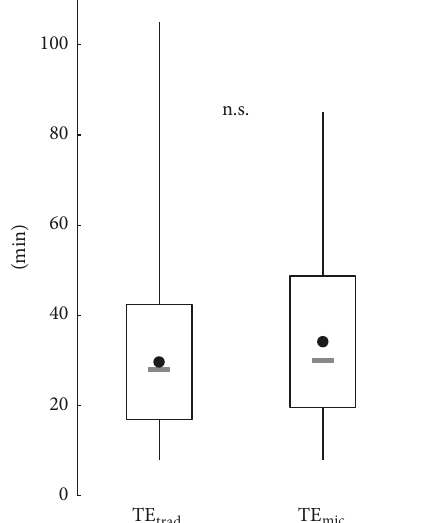
Figure 2: Procedural times in the study groups without the onco- logical cases (boxes represent mean ± standard deviation, whiskers represent the minimum/maximum, grey bars represent the median, and black circles represent the mean).